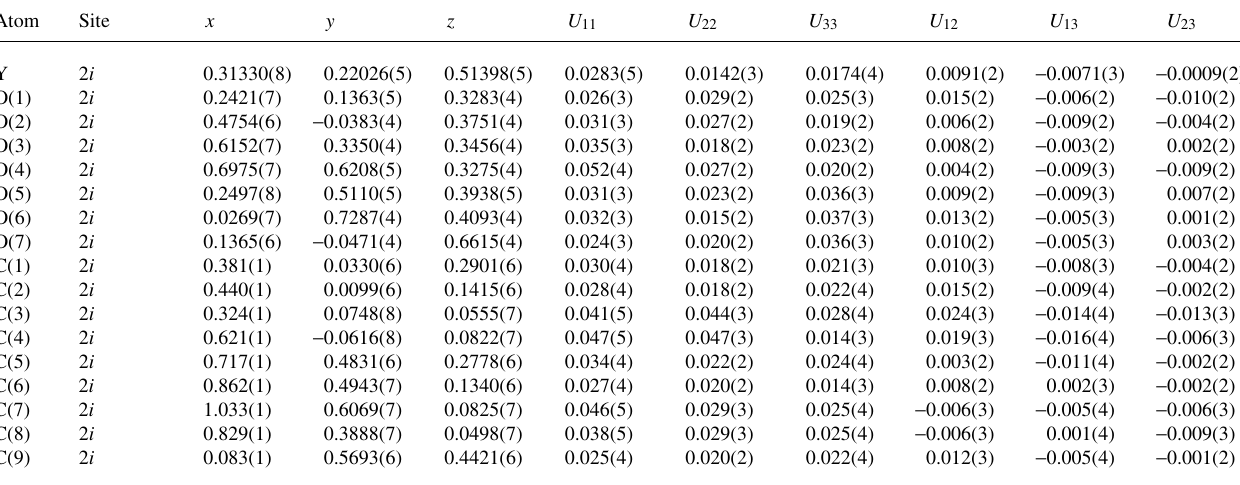
Table 3. Atomic coordinates and displacement parameters (in Å 2 )